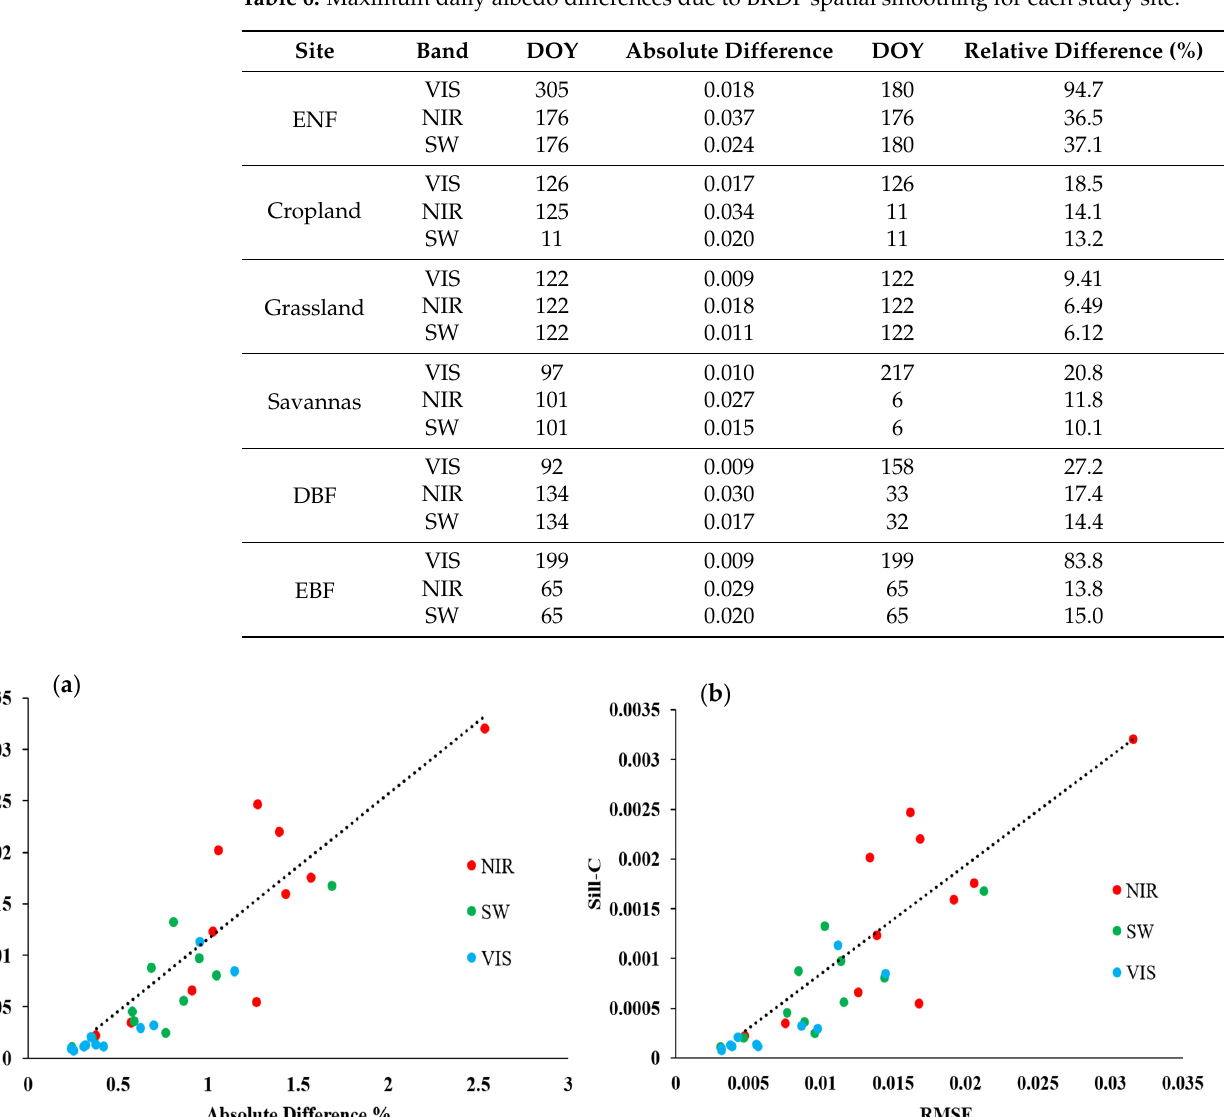
Table 6. Maximum daily albedo differences due to BRDF spatial smoothing for each study site.